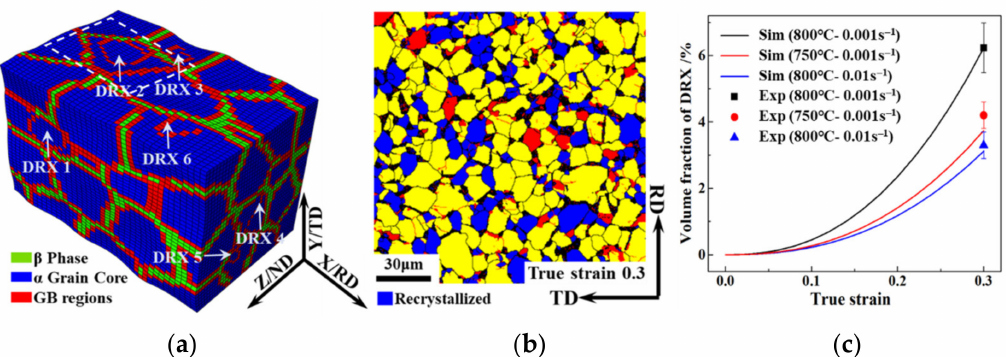
Figure 9. Simulated and experimental results of the recrystallised grains and fractions of the TA15 tensile samples (800 ◦ C–0.001 s − 1 –true strain 0.3). simulated ( a ) and experimental ( b ) recrystallised grains; ( c ) simulated and experimental recrystallised